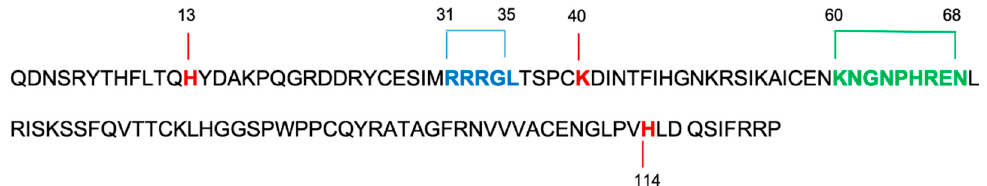
Figure 2. Amino acid sequence of angiogenin using one-letter symbols. The first residue Q, glutamine, is cyclized as pyroglutamate. Red indicates amino acids of catalytic sites (H, histidine; K, lysine); blue indicates nuclear translocation sequence (R, arginine; G, glycine; L, leucine); green indicates cellular binding site (K, lysine, N, asparagine; G, glycine, P, proline, H, histidine; R, arginine; E, glutamic acid).